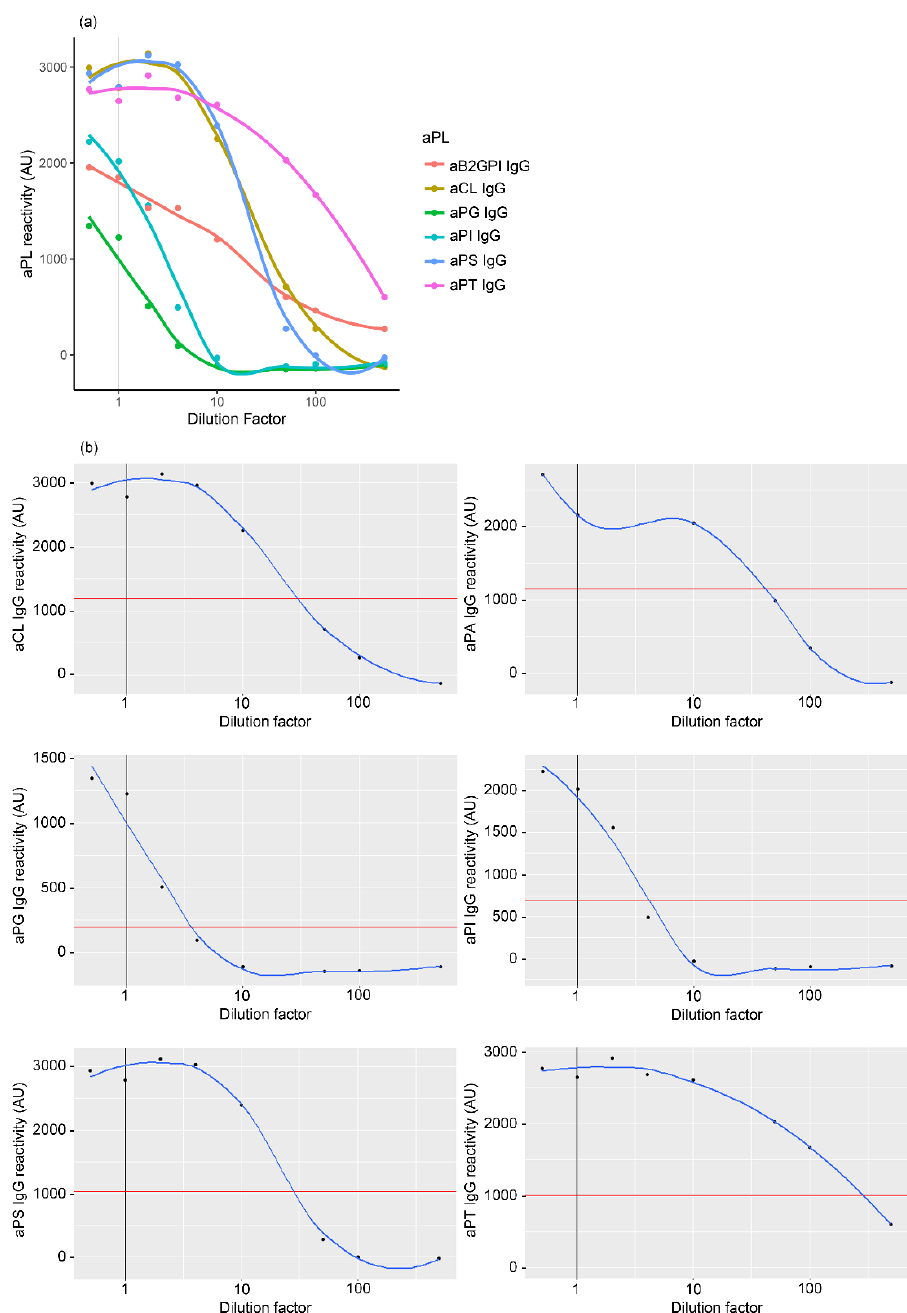
Figure 2. Quantification of the linear detection of antiphospholipid antibody (aPL). Serum from a triple-positive patient with antiphospholipid syndrome (APS) was serially diluted to assess aPL levels by line immunoassay (LIA). ( a ) Levels of different aPL were detected by LIA at the indicated dilutions. Dilution factor 1 (vertical grey line) designed the dilution recommended by the LIA manufacturer (1:33). The other dilution factors are in reference to this dilution factor 1. ( b ) Individual aPL levels for anti-cardiolipin (aCL) IgG (top left), anti-phosphatidic acid (aPA) IgG (top right), anti-phosphatidylglycerol (aPG) IgG (middle left), anti-phosphatidylinositol (aPI) IgG (middle right), anti-phosphatidylserine (aPS) IgG (bottom left), and anti-prothrombin (aPT) IgG (bottom right) at their respective dilution factors. Horizontal red line denotes the 99th-percentile value for each aPL. Experiments were performed in triplicate, showing the mean values of aPL reactivity reported in arbitrary units (AU) as indicated in Section 4.3 of Materials and